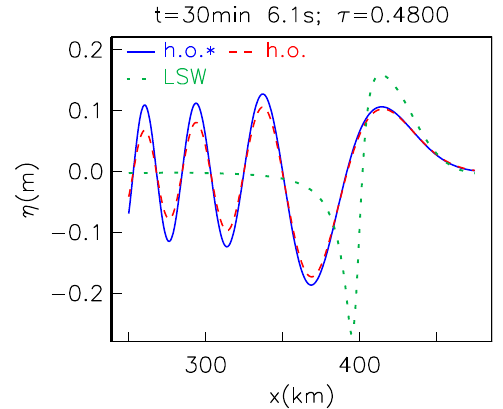
Fig. 5. The surface elevation along the y = 0 transect, for the wave